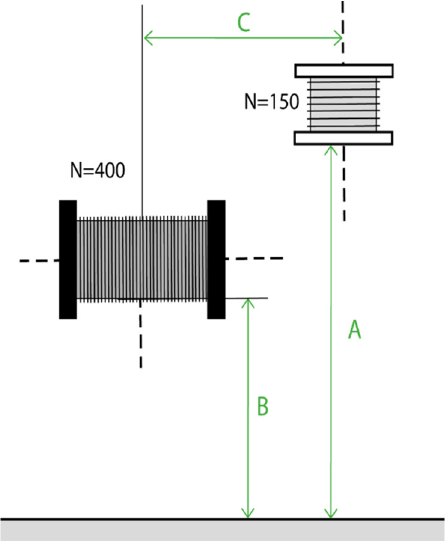
Figure 9. Diagram of the parameters to be varied during Test 4, horizontal arrangement.